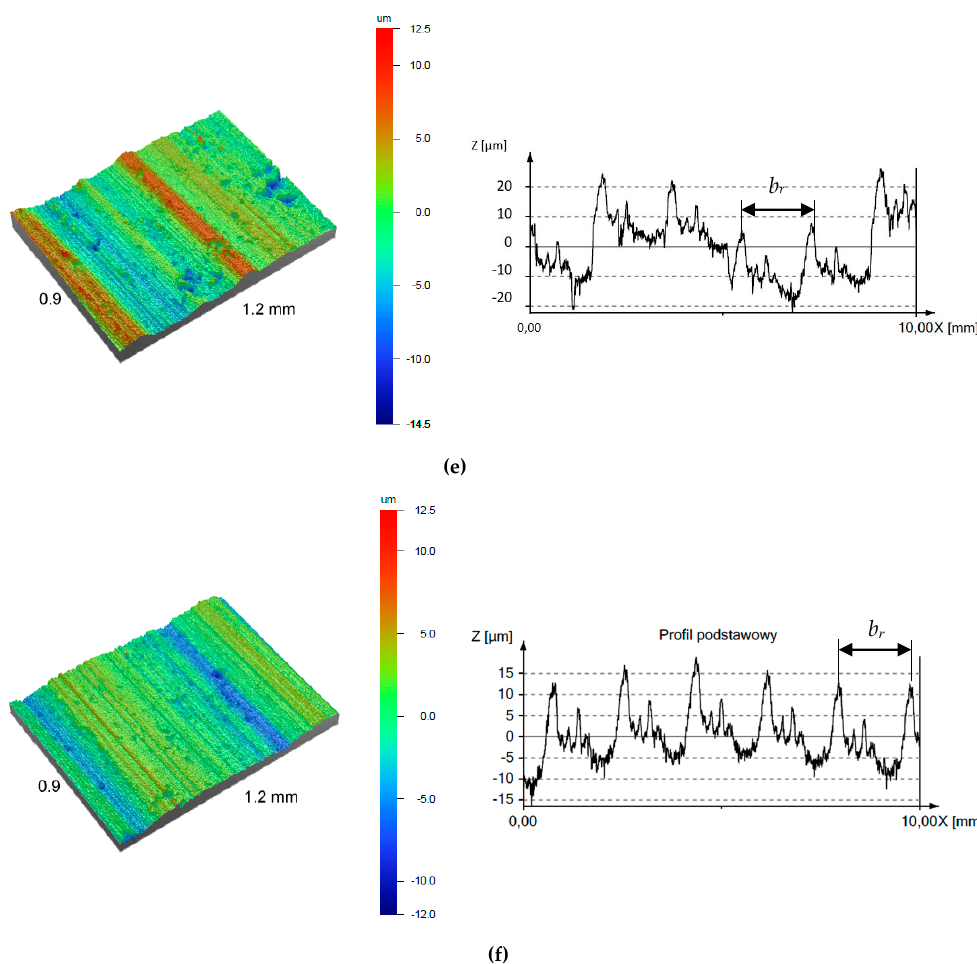
Figure 14. 3D topographies and 2D surface profiles of a machined surfaces of the AlSi13MgCuNi alloy after grooving with a DDCC insert in the range of: ( a ) v c = 50 m/min; ( b ) v c = 100 m/min; ( c ) v c = 200 m/min; ( d ) v c = 400 m/min; ( e ) v c = 600 m/min; ( f ) v c = 800 m/min.